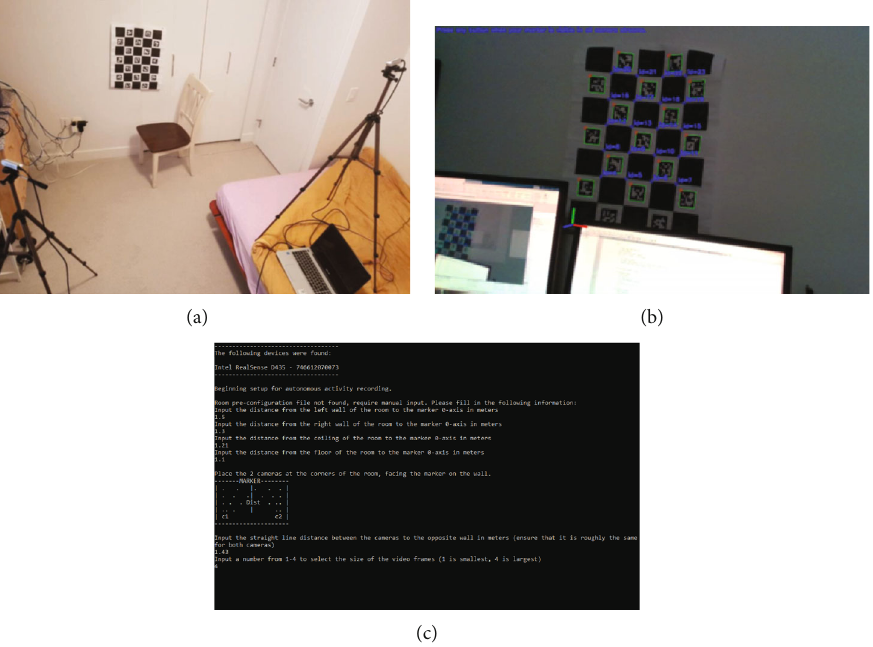
Figure 3: Initialization steps for setting-up the monitoring environment for our study: (a) a typical monitoring area showing the placement of two RGB-D sensors and the calibration prop/object; (b) the resolved world coordinate associated with the monitoring area (red, green, and blue coordinate axes). This coordinate system is then used to merge point clouds obtained from all sensors. (c) Complementary calibration follow-up procedure for associating the physical dimensions of the monitoring scene to the sensed information.